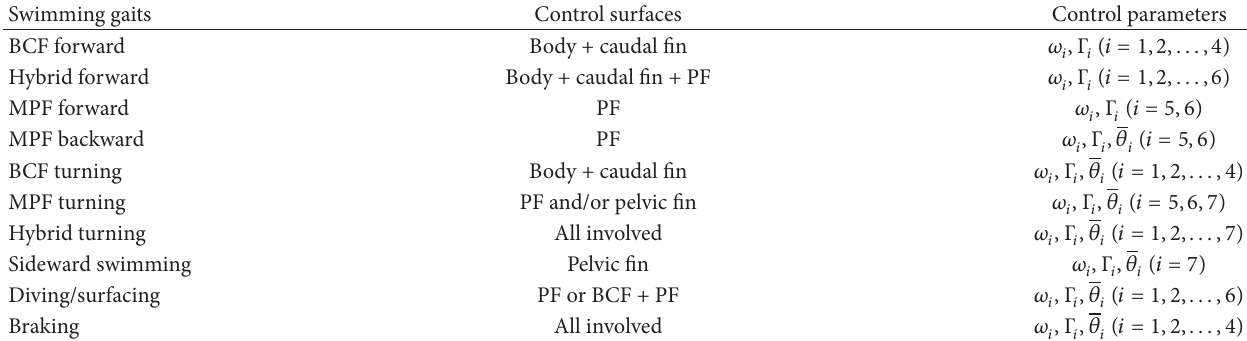
Table 1: The relations between swimming gaits and control surfaces.